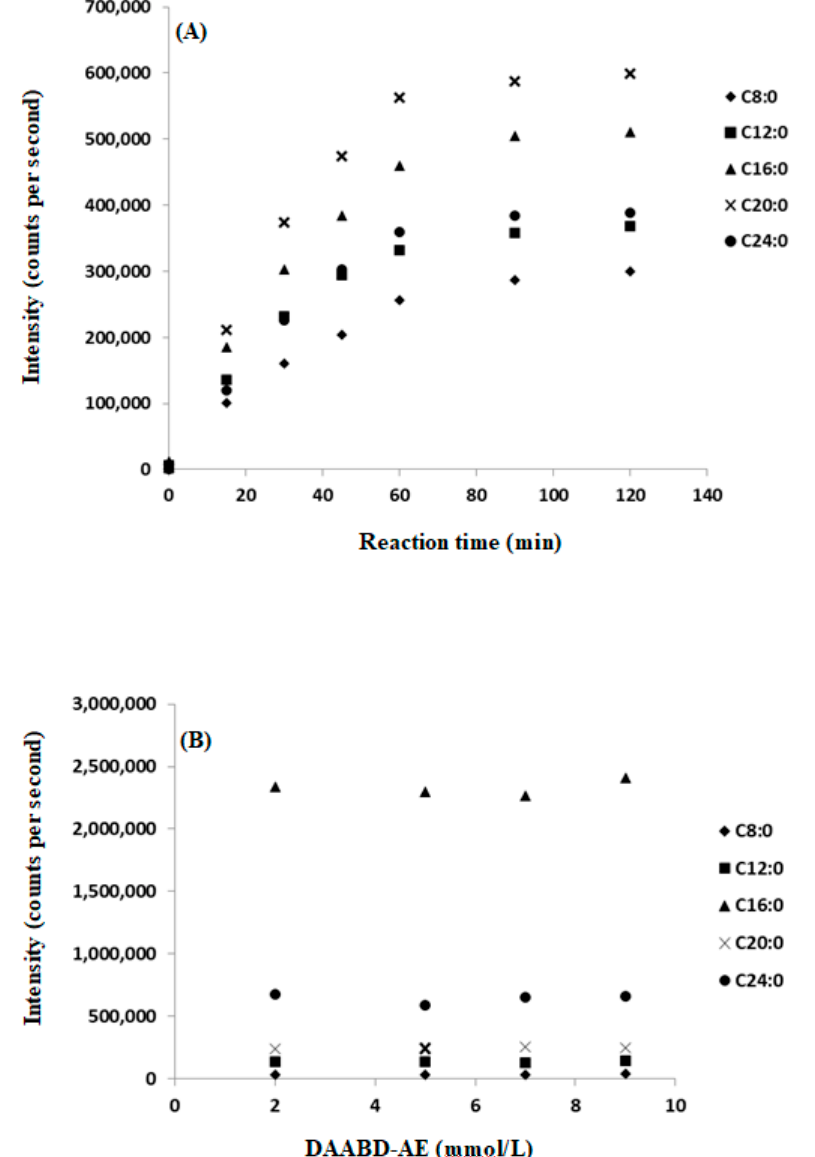
Figure 3. Derivatization yield of DAABD-FAs as a function of time ( A ), and the effect of DAABD-AE concentration on the derivatization yield ( B ).